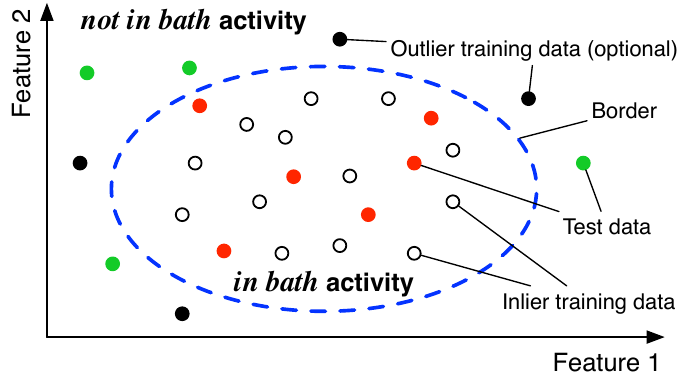
Figure 5. Example of bathroom activity classification using anomaly